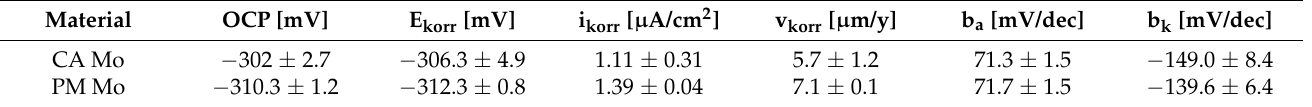
Table 4. Measurement data for electrochemical analyses on pure